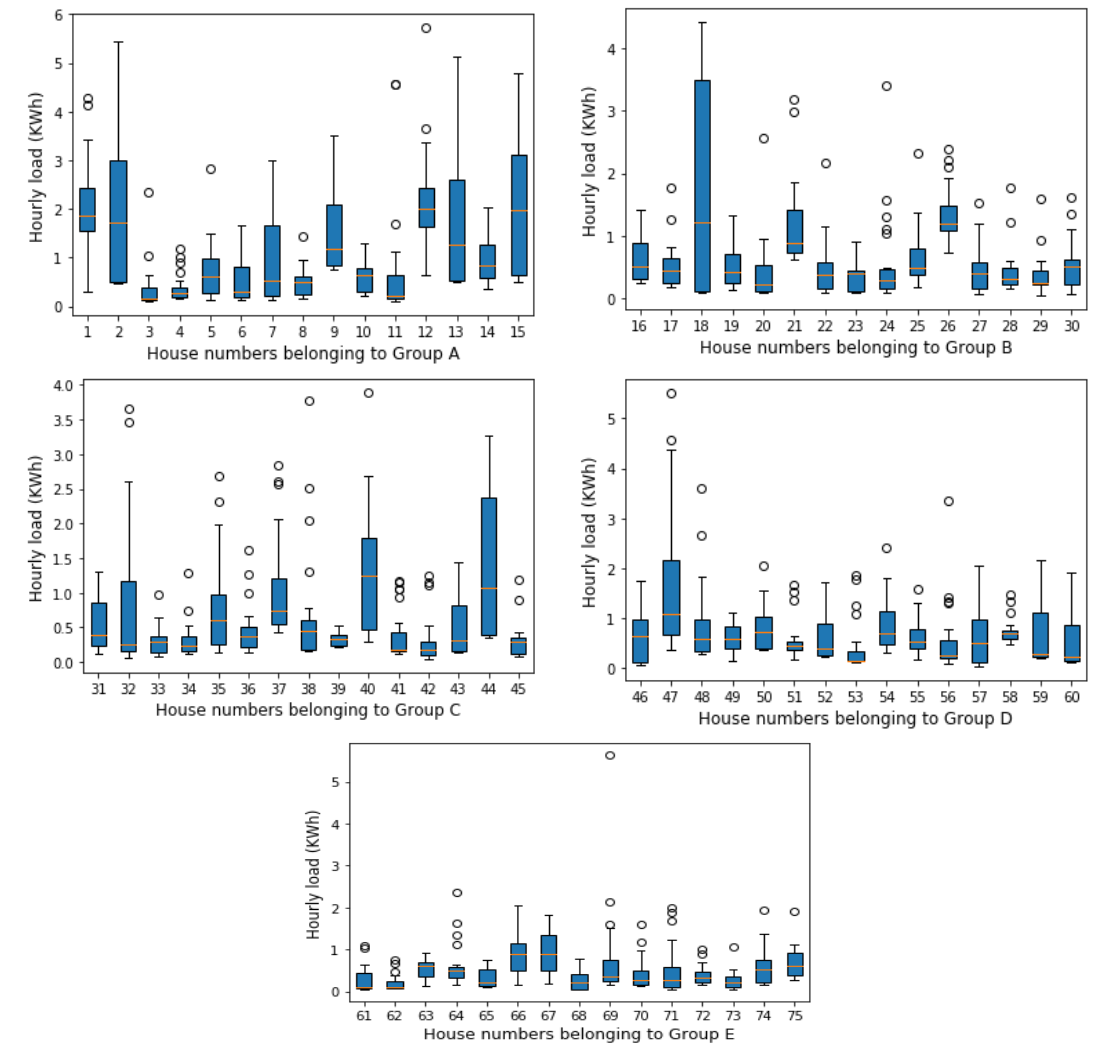
Figure 6. Boxplot statistics for 75 houses in a working day 2013 March 25.